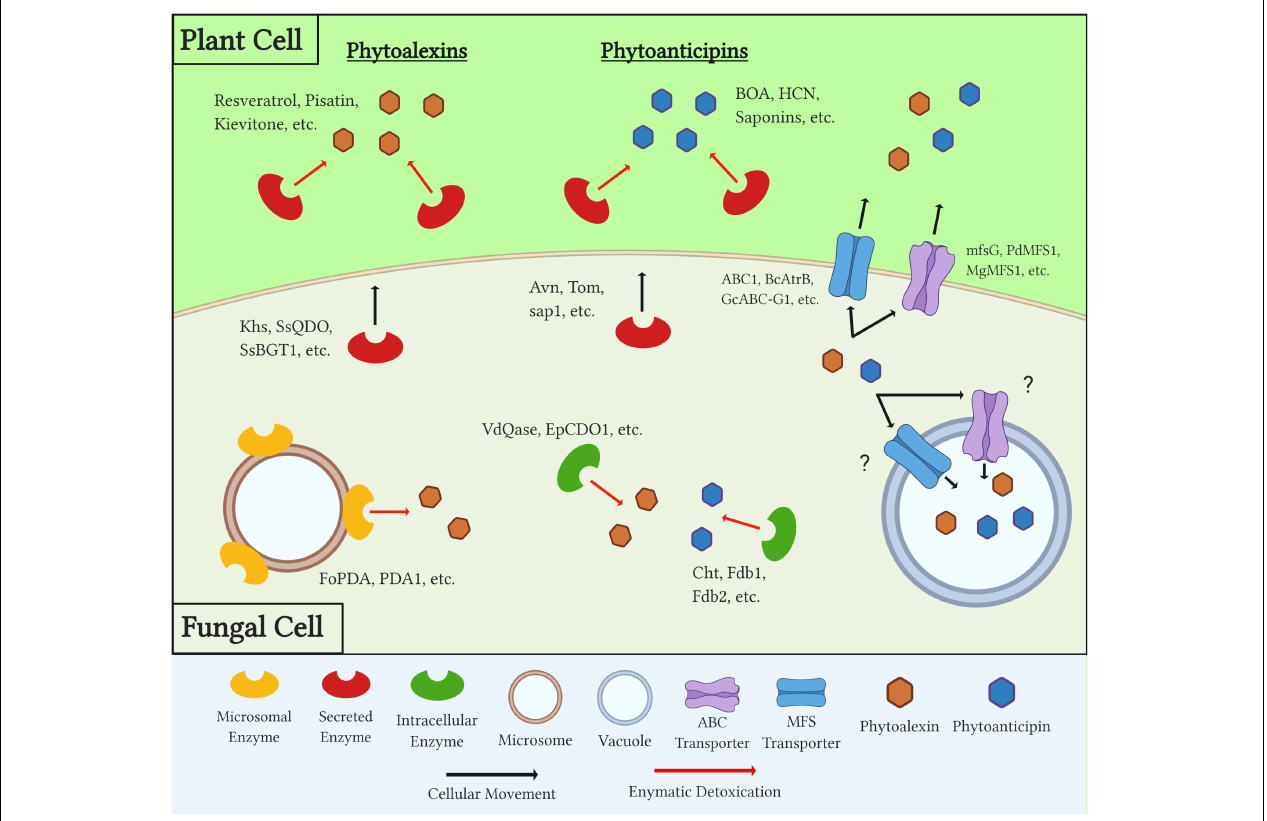
FIGURE 2 | Diagram outlining generalized mechanisms of fungal tolerance for preformed and inducible plant defense compounds (PDCs). Examples of each class of PDC, detoxification enzyme, and transporter are included. Question marks denote a mechanism which is suspected but has yet to be confirmed through experimental